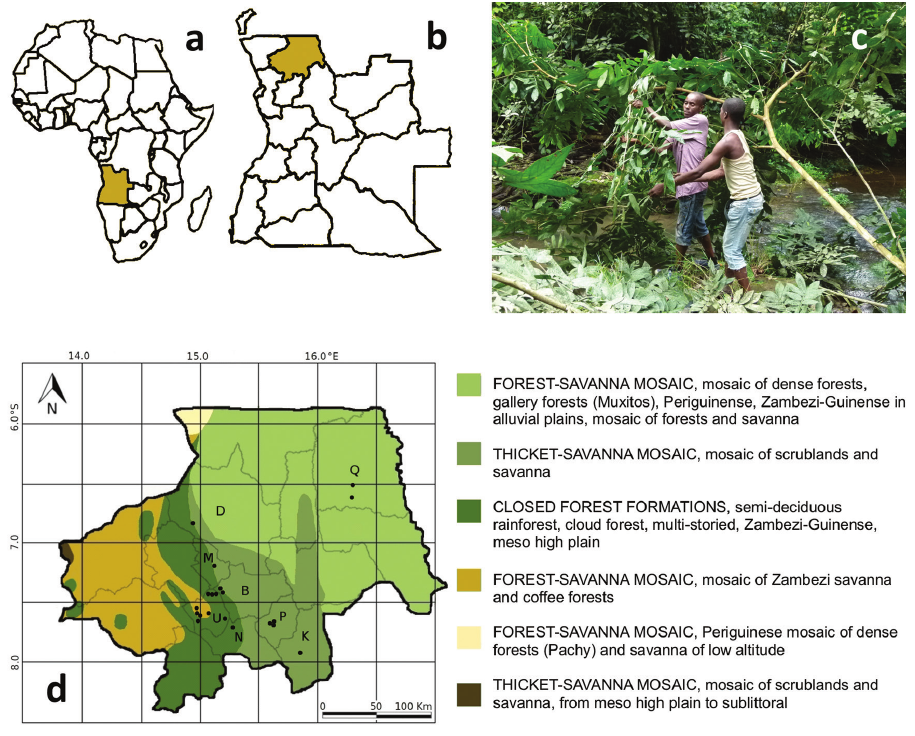
Figure 1. Study area. a Location of Angola in Africa b Province of Uíge in Angola c Collectors of caterpillars cutting a host tree to collect larvae d Sample points of edible insects including several species according to Table 2. Vegetation zones according to Barbosa